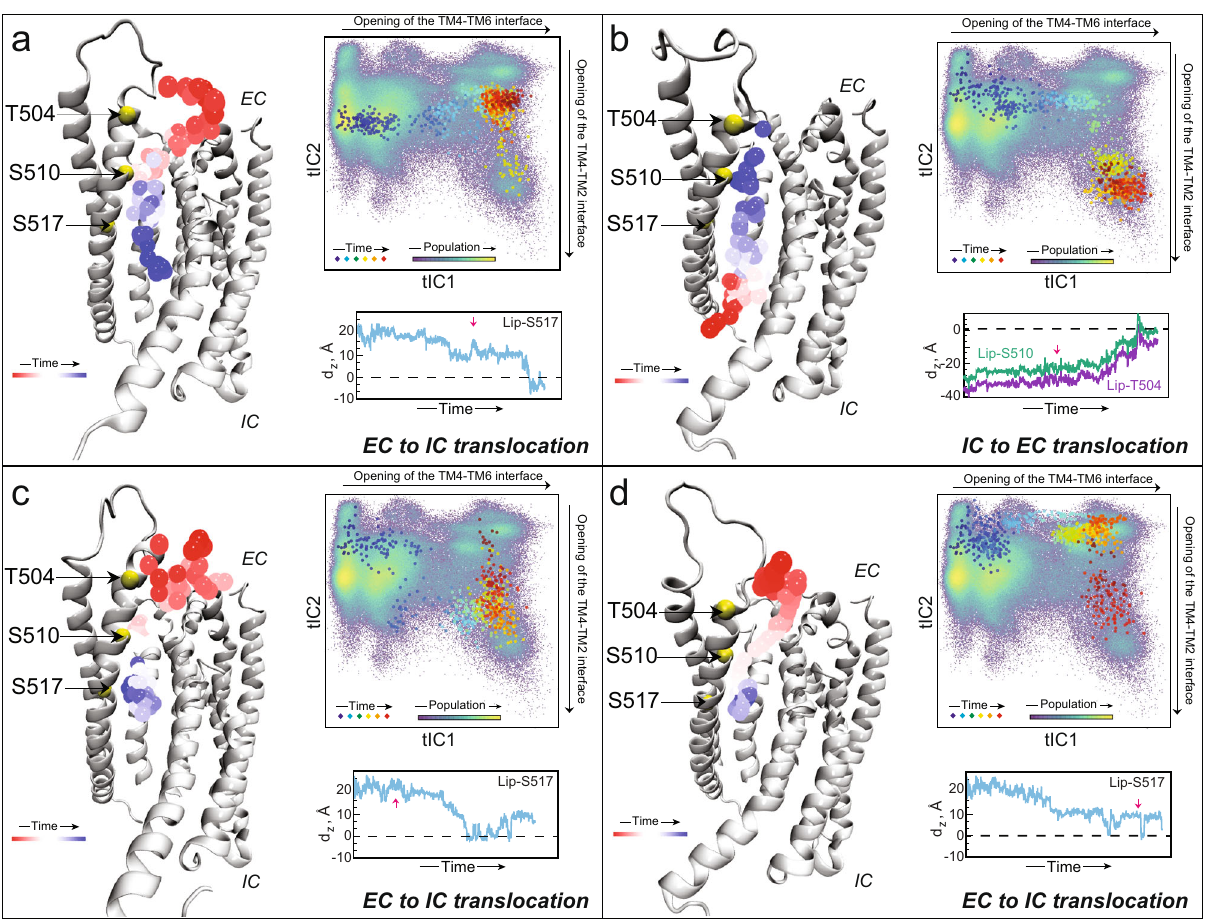
Fig. 6 Events of lipid scrambling through the open mTMEM16F groove. The four panels depict lipid scrambling events from four different trajectories. a , c , and d Describe lipid translocation from the EC to IC side; b describes lipid translocation from the IC to EC side. In each panel, the protein monomer is the structure taken from the fi nal frame of the respective simulation trajectory, shown in cartoon. The trajectory of the scrambled lipid is represented by the phosphorus atom shown as spheres colored according to the timestep (see “ Time ” color bar). The C α atoms of residues T504, S510, and S517 are shown as yellow spheres. The time evolution of the corresponding MD trajectory projected onto the 2D tICA landscape from Fig. 3 is shown as large colored dots with darker colors (blue, cyan) indicating the initial stages of the simulation, lighter colors dots (yellow, green) corresponding to the middle part of the trajectory, and red shades showing the last third of the trajectory (the color map of the tICA space itself identi fi es the populations distribution of the different states of mTMEM16F with lighter and darker shades corresponding to the high and low density states, respectively). The directions on the tICA space along which TM4-TM6 and TM4 – TM2 interfaces open are indicated outside the map, by arrows along the upper border and right border, respectively. The framed time plot in each panel shows the time-evolution of the distance between the phosphorus atom of the scrambled lipid as the Z-distance between the headgroup of the scrambled lipid and the C α atom of residue S517 (d Z S517 , blue trace) in a , c , and d . In b , the plot shows the distance of the headgroup and residues T504 and S510 (d Z S504 and d Z S510 , purple and green traces, respectively). The lipid was considered scrambled in the EC to IC direction if during the trajectory d Z S517 became < 0, while in the IC to EC direction the lipid was considered scrambled if during the trajectory d Z T504 became > 0. The red arrows on the Z-distance plots mark the time-points in the trajectory when the TM4 – TM2 interface of the groove is fully open (i.e., the system enters microstate 10). The headgroups of POPE and POPG lipid were de fi ned as the center-of-mass of the following group of atoms (in CHARMM36 nomenclature): for POPE – N, C12, C11, P; for POPG – C13, OC3, C12, C11, and